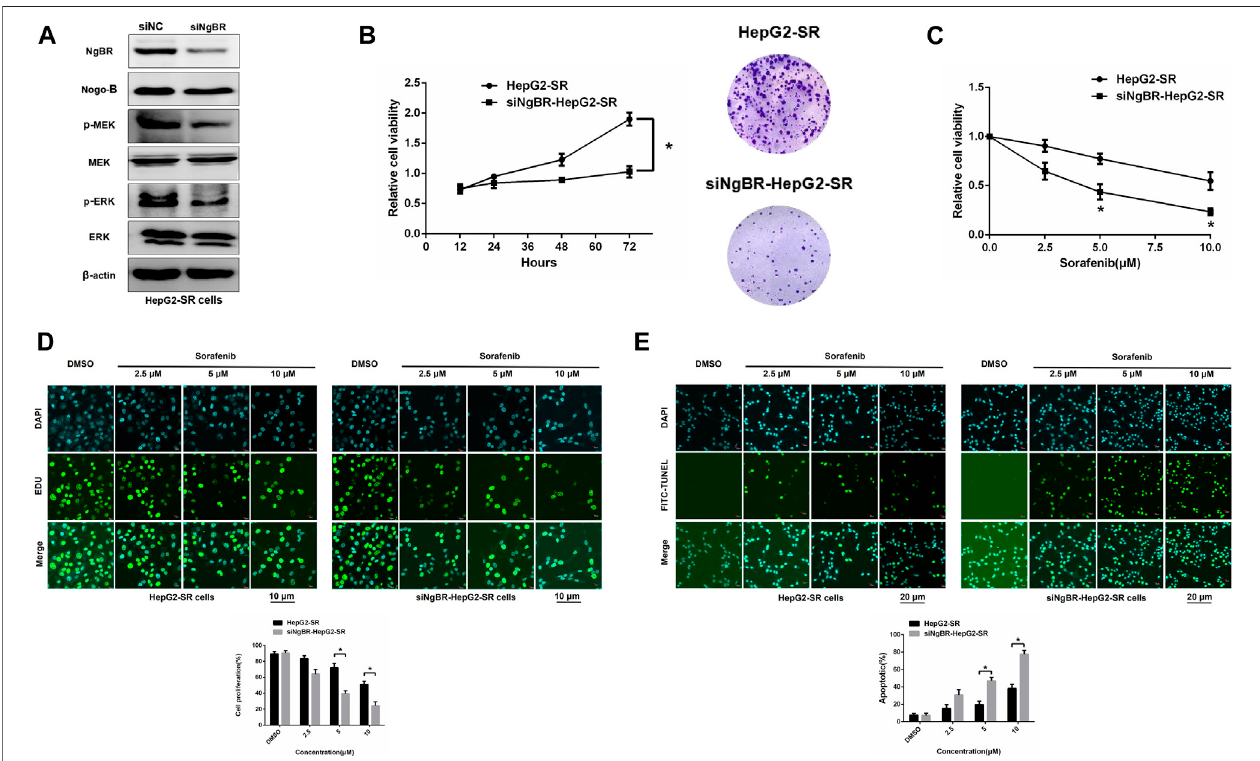
FIGURE 3 | NgBR knockdown reduces sorafenib resistance. (A) . NgBR knockdown ef fi ciency of was assessed via western blotting. (B) . Cell growth of NgBR knockdownandnormalcontrolHepG2-SRcellswasmeasuredbyMTT(72 h)andcolonyformation(14days)assays.Dataarepresentedasmeans ± standarddeviation (SD). (C) .HepG2-SRcellsweretreatedwithvariousdoses(0,2.5,5,and10 μ m)ofsorafenib.After48 h,theMTTassaywasusedtodetectsorafenibsensitivity. (D) .Cell propagation was detected by EDU assays. Scale bars, 10 μ m. (E) . Apoptosis was detected by FITC-TUNEL staining. Scale bars, 20 μ m. Experiments were repeated three times and data are presented as mean ± SD. Student ’ s t -test was used to analyze data. * p <